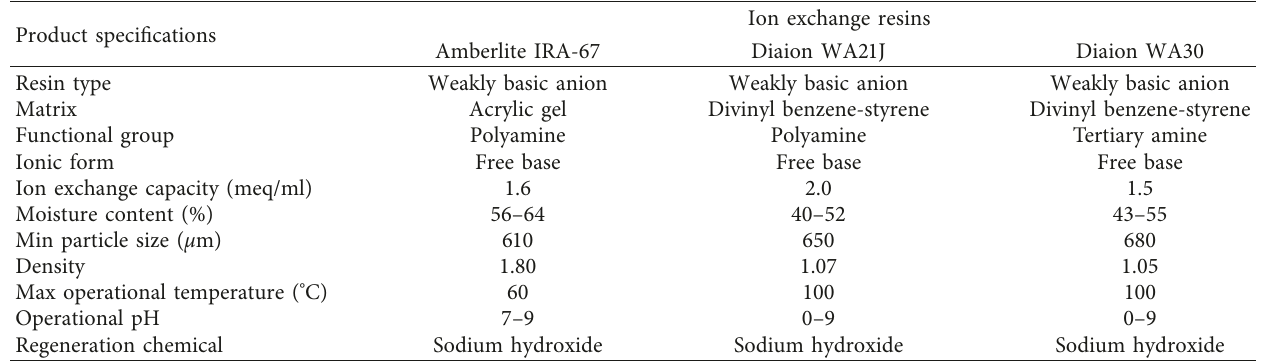
Table 1: Specification of each ion weakly basic anion exchange resin chosen for the adsorption of saponin from C. papaya leaves. Product specifications